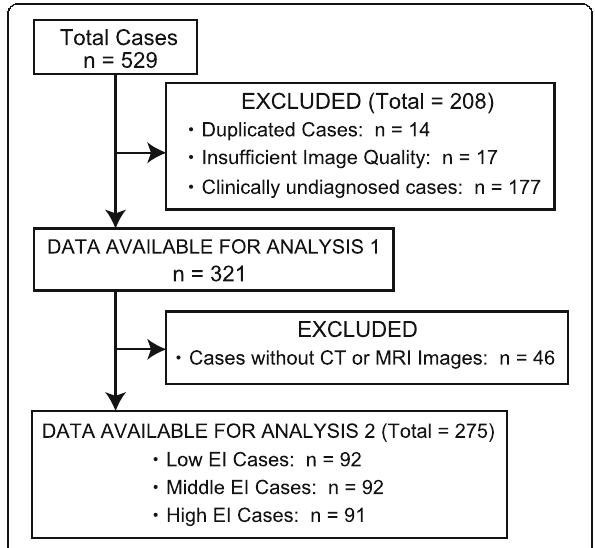
Fig. 1 Flow diagram of patient enrollment, eligibility, and exclusion criteria of the dataset. CT computed tomography, MRI magnetic resonance imaging, EI Evans